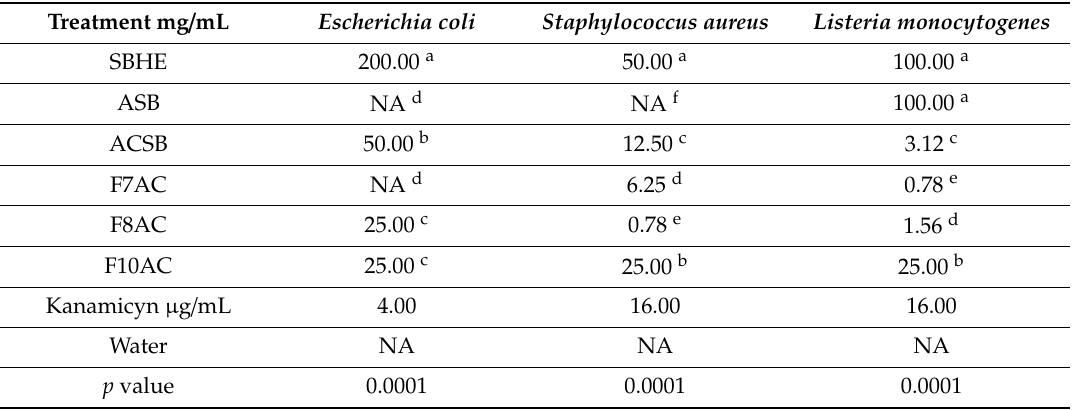
Table 2. Minimal Bactericidal Concentration of the Salix babylonica hydroalcoholic extract and fractions against Escherichia coli, Staphylococcus aureus, and Listeria monocytogenes. Treatment mg/mL